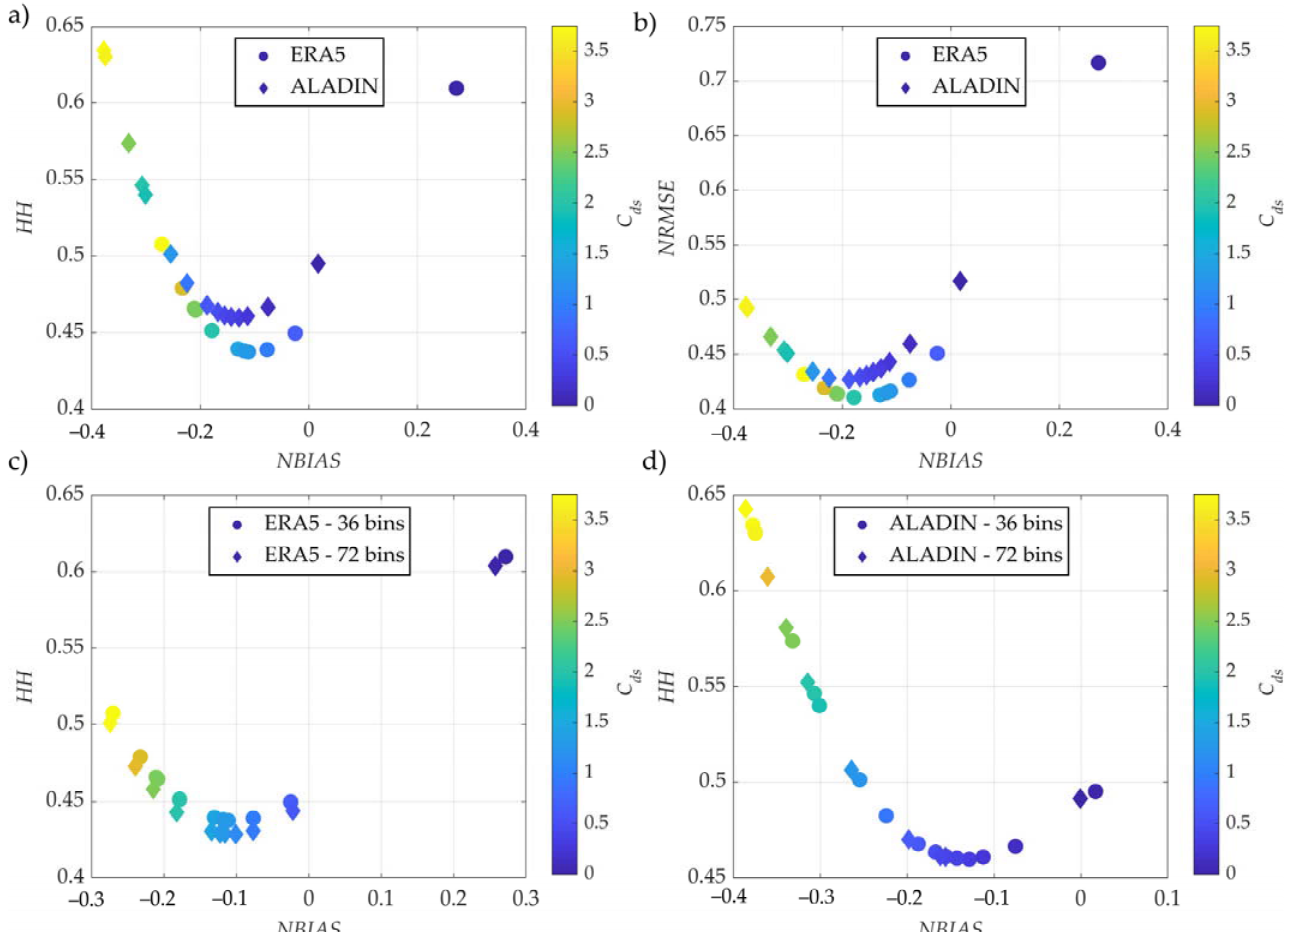
Figure 7. Performance metrics of ERA5 and Aladin reanalysis forced wave numerical model at wave buoy in front of Split (Figure 1). ( a ) Comparison of wind data reanalysis sources for different white ‐ capping coefficient values C ds in relation to HH and NBIAS ; ( b ) Comparison of wind data reanalysis sources for different white ‐ capping coefficient values C ds in relation to NRMSE and NBIAS ; ( c ) Comparison of the influence of different wave directional resolution with ERA5 wind reanalysis data; ( d ) Comparison of the influence of different wave directional resolution with ERA5 wind reanalysis data. The large overestimation of winds at the Hvar station for the ERA5 driven numerical model (Figure 6), located in the middle of the numerical domain, contributed to a higher calibrated white ‐ capping coefficient for wave dissipation. A higher white ‐ capping parameter of 1.35 demonstrated superior performance of the model because the overestimated wind data must be suppressed by the white ‐ capping wave dissipation mechanism. This is in contrast to the often ‐ cited underestimations of wind data by the global wind reanalysis models.